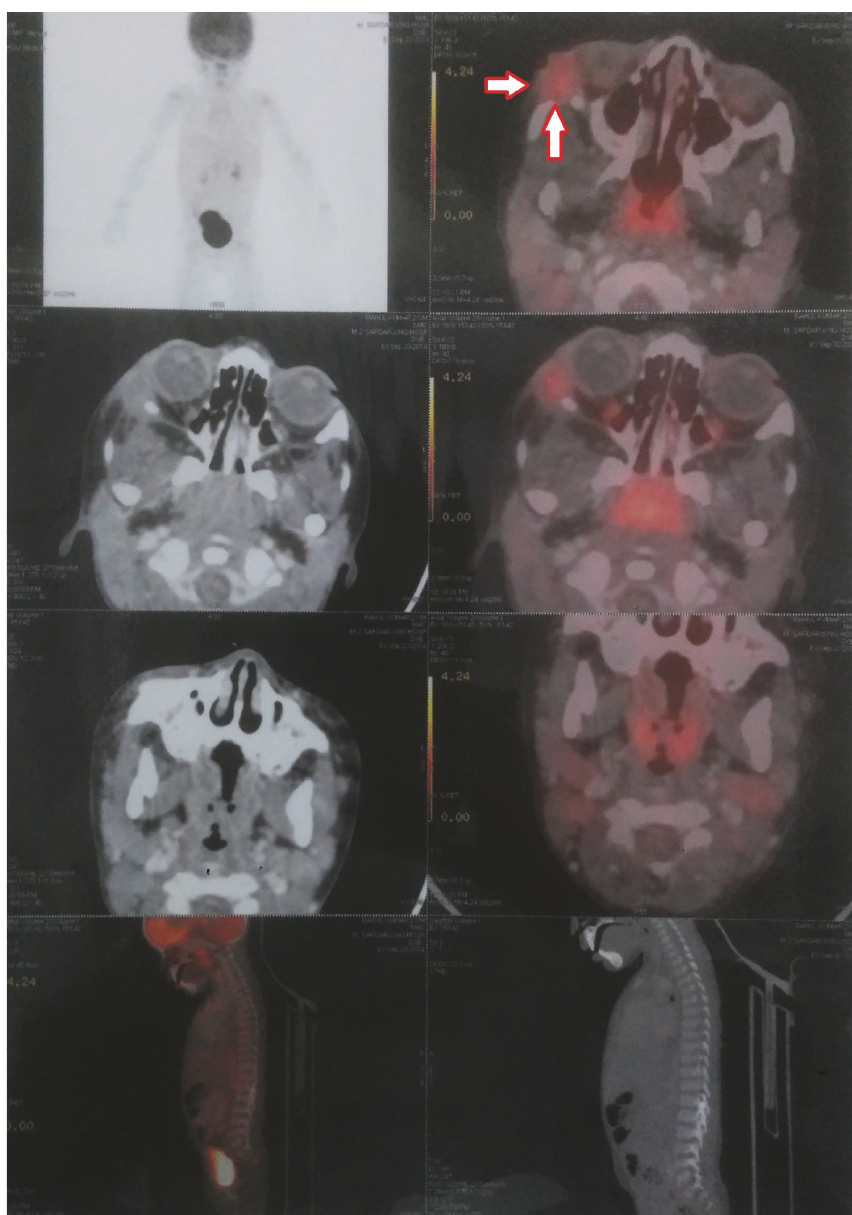
Figure3:PET-CTscanwitharrowsmarkedshowingincreaseduptakesuggestiveofincreasedactivityatthesiteoftheeosinophilicgranuloma (Langerhans Cell Histiocytosis).